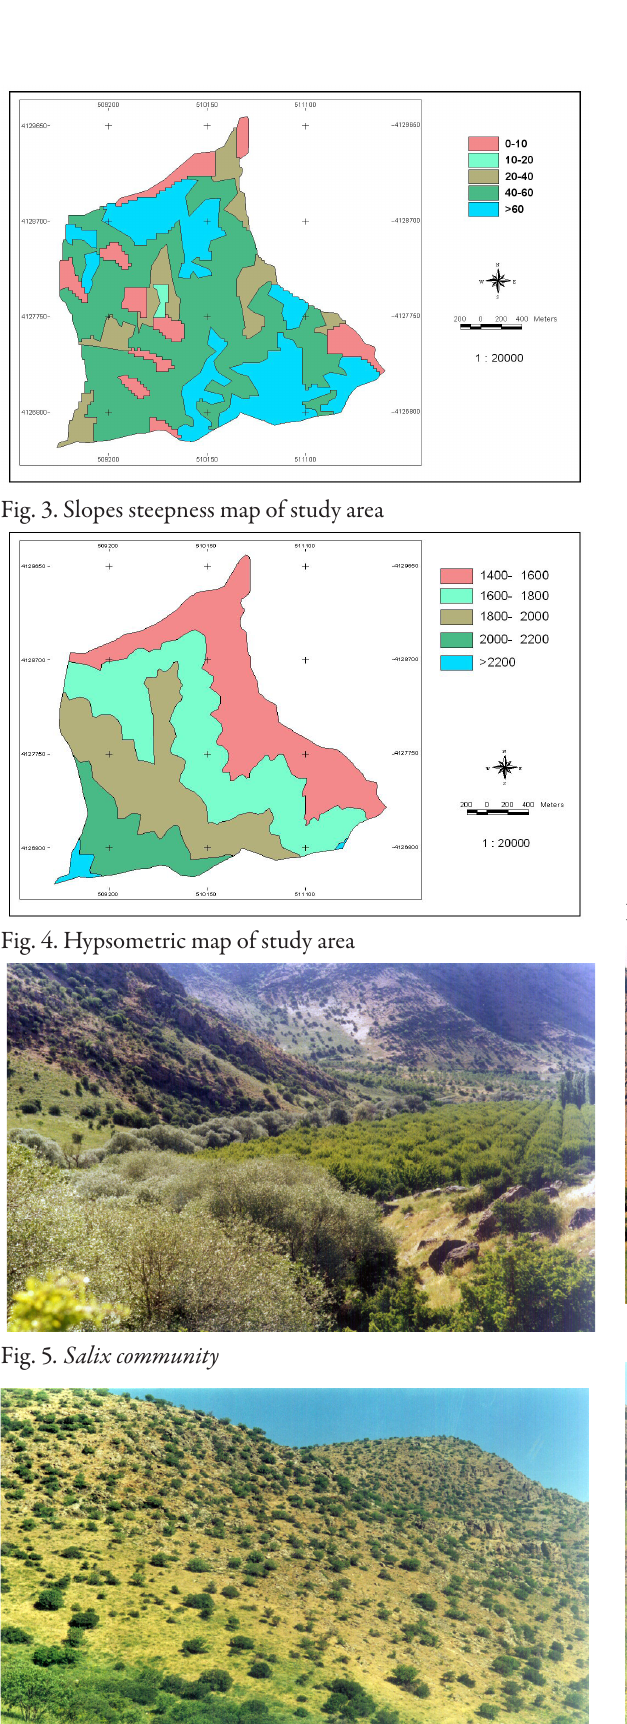
Fig. 6. Acer-Amygdalus pabotii- Pistacia community